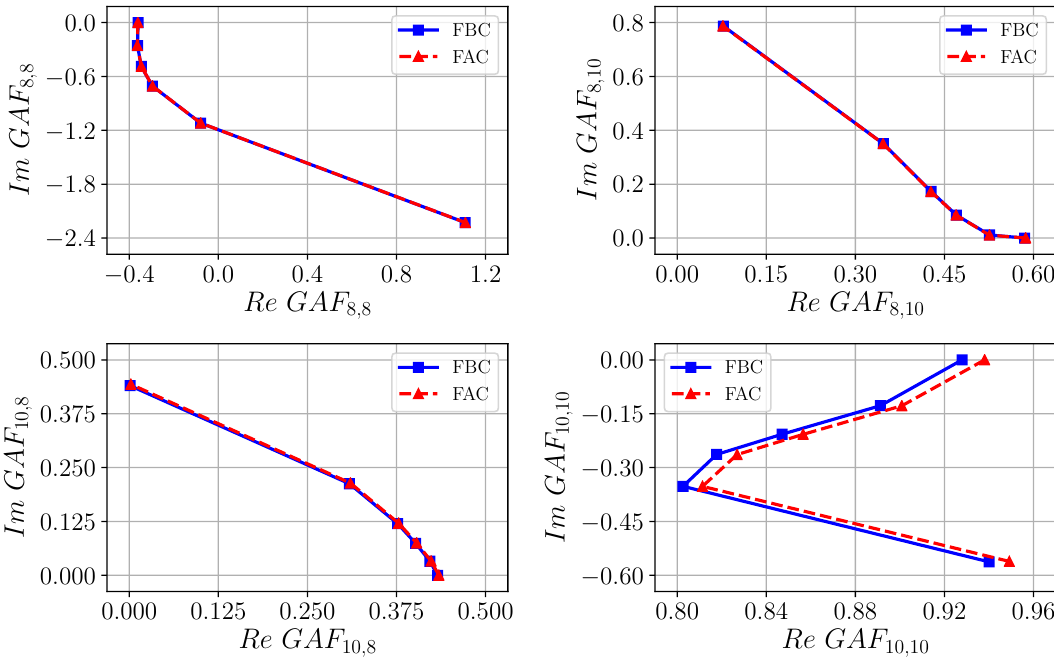
Figure 26. Comparison of the FBC and the FAC with regard to resulting GAF entries of the dominant flutter modes at k red = [ 0.0; 0.1; 0.2; 0.3; 0.5; 1.0 ] .